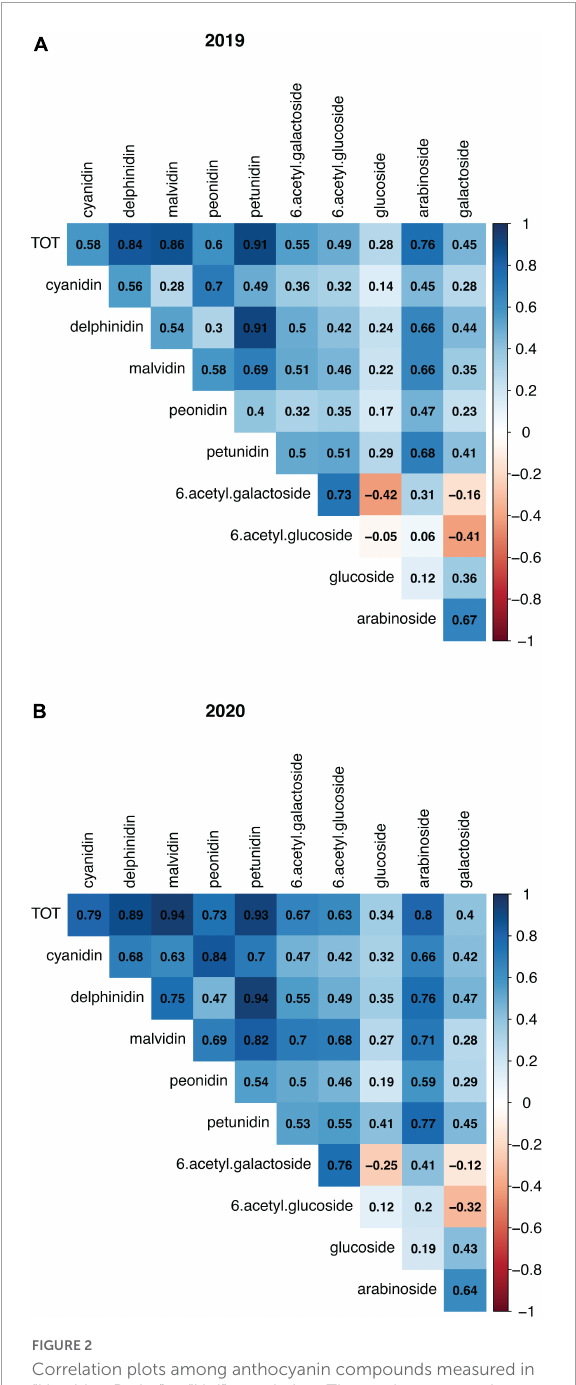
concentrations of the single anthocyanin compounds, large variation appeared to be accounted for by the PC1 and PC2 (31.3 and 22.3%, respectively, in 2019, and 33.5